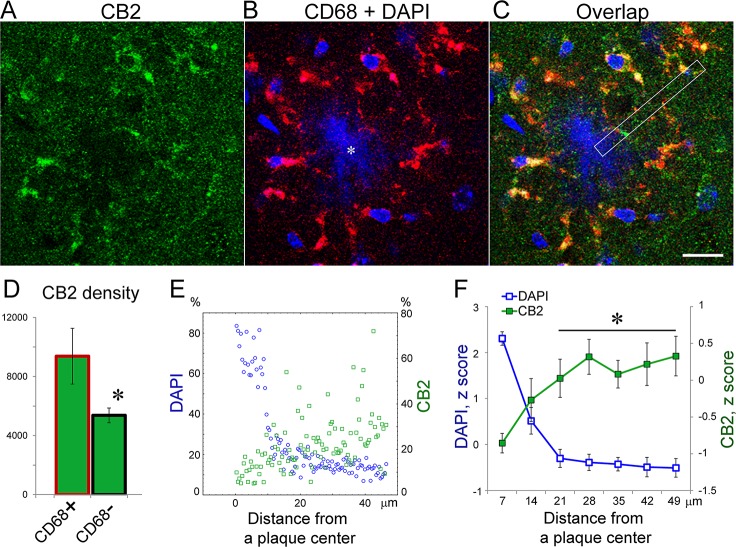
CB2 receptors are expressed in microglial cells and do not accumulate in Aβ plaques of APPswe/PS1ΔE9 mice.A representative confocal image of staining for CB2 receptors (green, H60 antibody) in the cortex of 12 mo-old transgenic mice. (B) An overlap of red (CD68) and blue (DAPI) channels for the image shown in A. Note a characteristic gathering of activated microglia around an amyloid plaque (marked by an asterisk). (C) An overlap of channels shown in A-B. Note that areas with high CB2 intensities overlap with CD68-positive areas. White rectangle shows an example of areas used for quantifications presented in E-F. Scale bar is 15 μm. (D) Quantification of CB2 densities (integrated intensities/area) in CD68-positive and –negative areas. 26 areas like that shown in A-C were used for the quantification (n = 2 transgenic mice). Asterisk indicates a significant difference between CD68+ and CD68- areas (one-way ANOVA, p<0.0001). (E) A scatterplot of CB2 and DAPI intensities as a function of distance from the center of an Aβ plaque with radius ~10 μm. Note low CB2 signal in the core of the plaque. CB2 and DAPI intensities were normalized (%) to a maximum signal on each channel. An example of an area used for calculations is shown by a white rectangle in C. (F) Quantification of CB2 signal at different distances from a plaque center. 4–6 slices of z stacks from five plaques (range of radiuses 7–15 μm) were used in one-way ANOVA. Asterisks indicate a significant increase (p<0.0001, post-hoc test) in CB2 intensities as compared to the core of plaques (radius ≤ 7 μm).